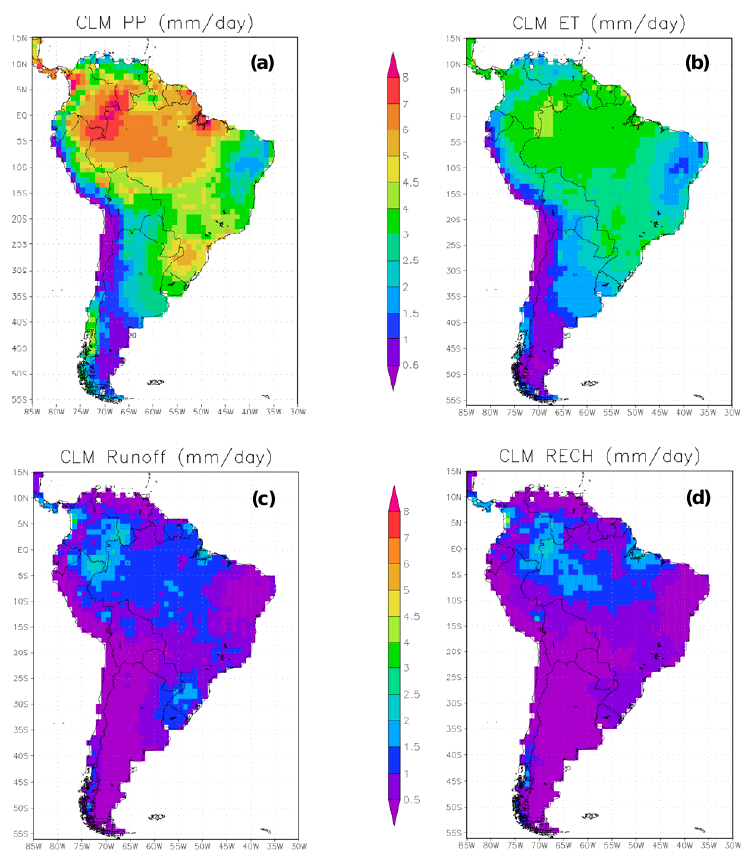
Fig. 8. CLM long-term (1979-2008) mean water balance: (a) precipitation P, (b) ET flux, (c) surface runoff Qs, and (d) water table recharge R, all in mm/day. The latter is estimated as R=P-ET-Qs.